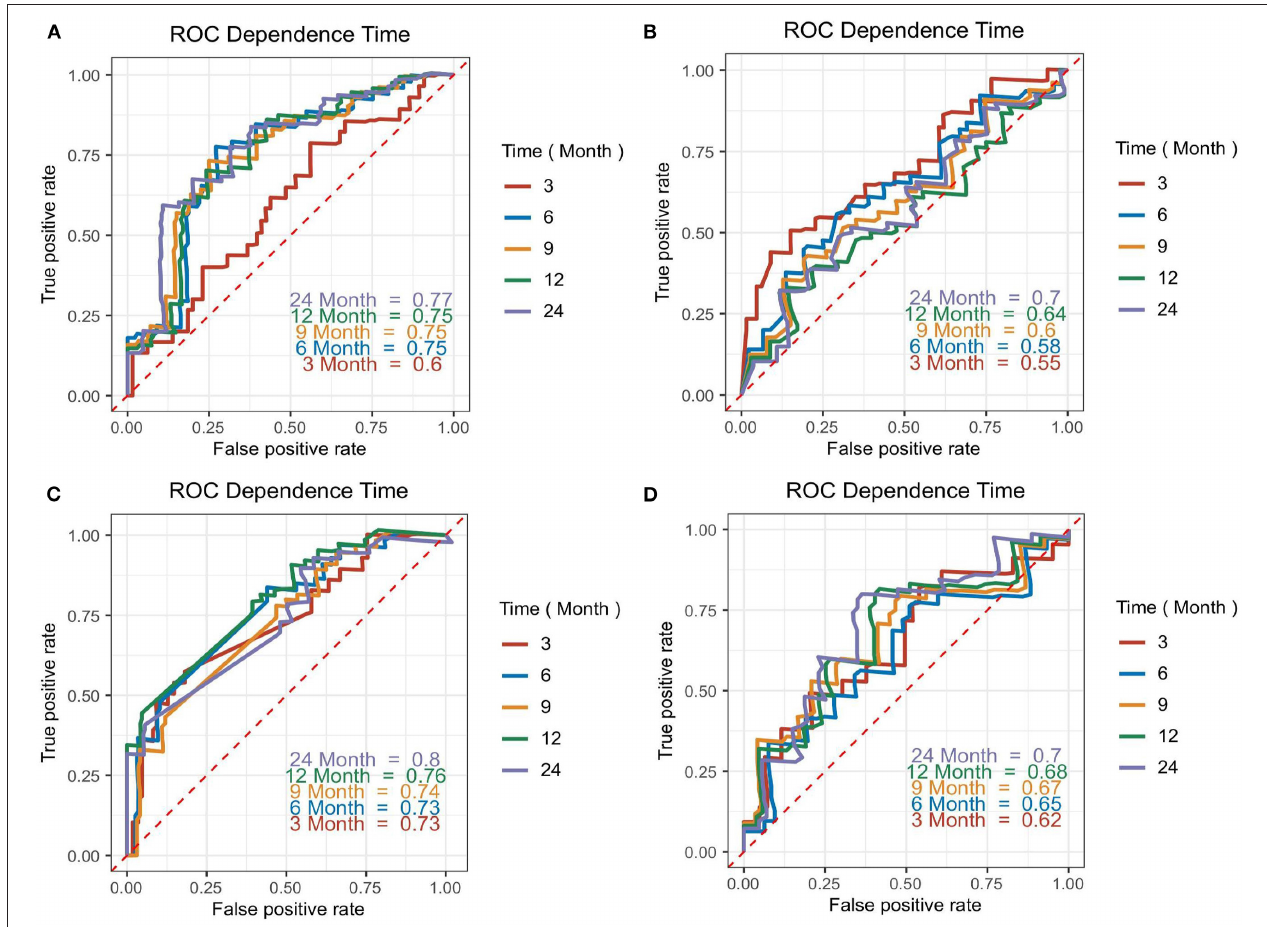
FIGURE 4 | Time-dependent ROC (t-ROC) curves for CA 125 (A) , N-terminal pro-B-type natriuretic peptide (NT-proBNP) (B) , cardiac troponin T (C) , and lactate dehydrogenase (LDH) (D) models. The area under the curve (AUC) presented the accuracy of predicting overall survival time (from diagnosis confirmed) for each biomarker at various time